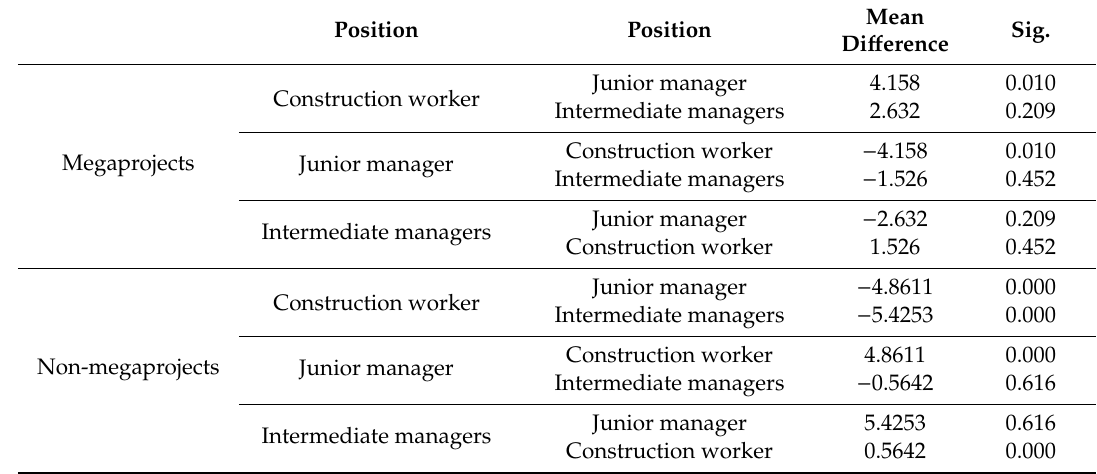
Table 9. Post hoc